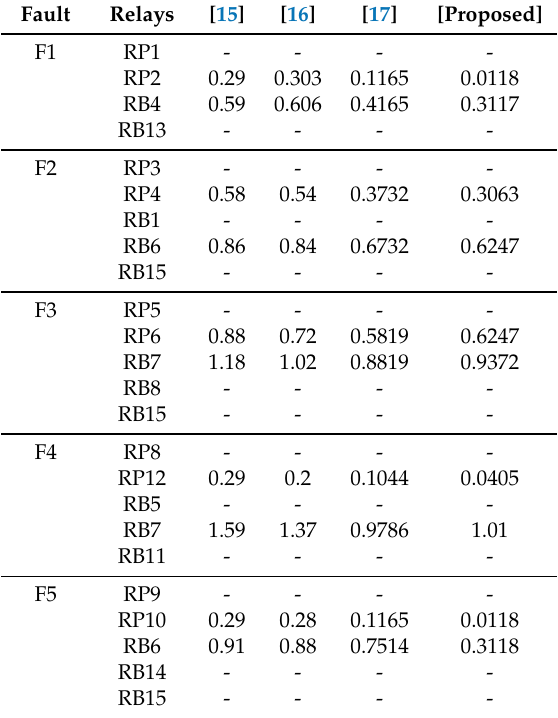
Table 5. Operation times for